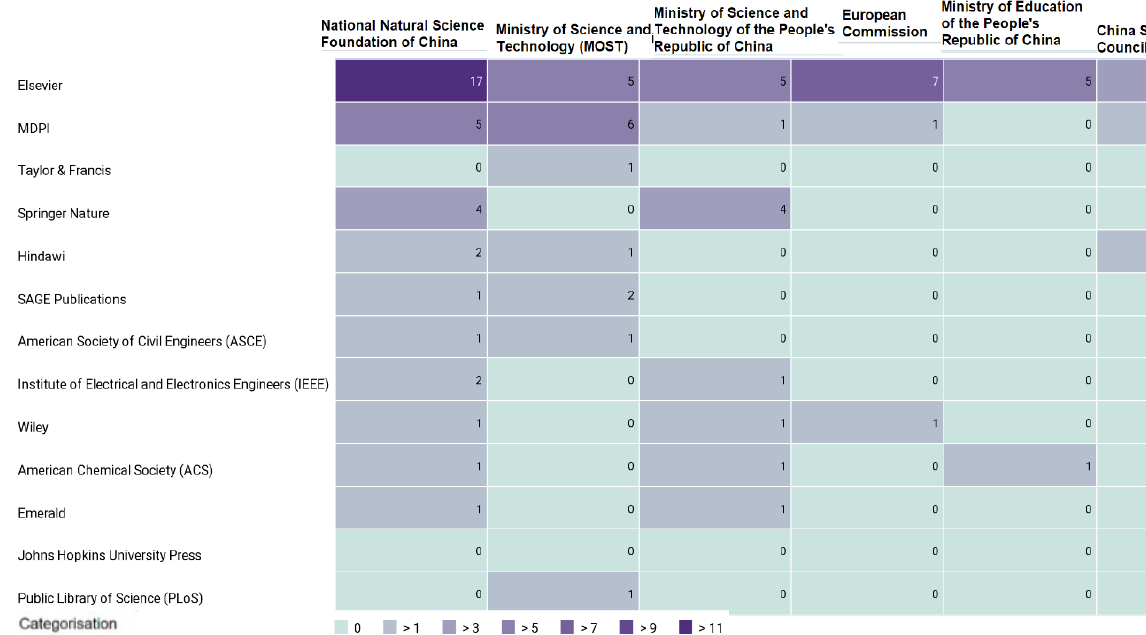
Figure 11. Peering Publishers and Funders in Figure 11 . Peering Publishers and Funders in Aerotropolis .